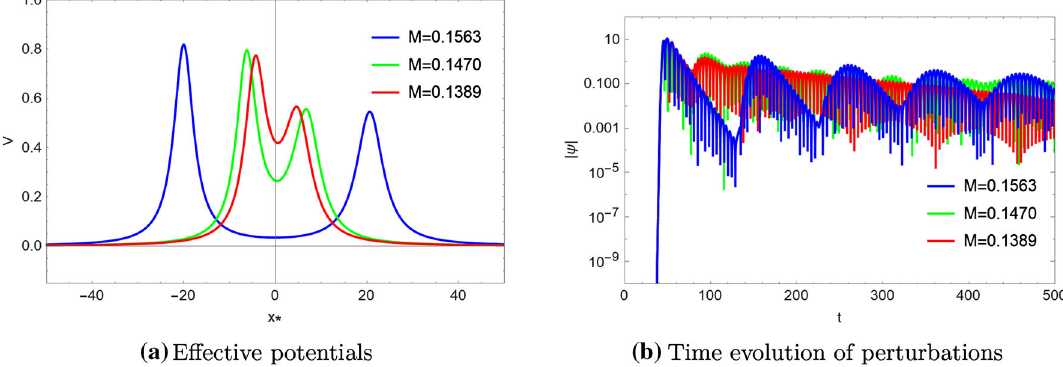
Fig. 4 The effective potentials and the corresponding time evolution profiles with different M . We set γ 1 = − 10 ,γ 2 = 2 , l = 2 , Q = 1